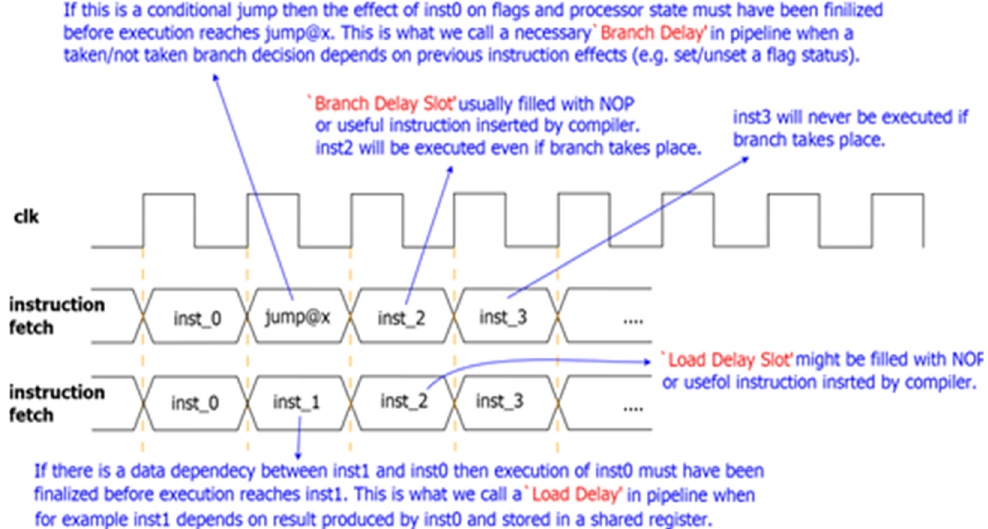
Figure 2. Branch and load delay—branch and load delay